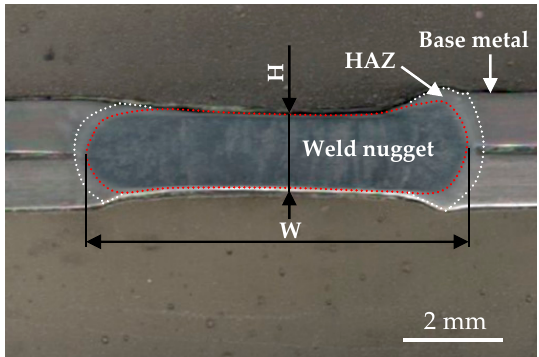
Figure 4. Typical cross-section of the spot welded joint.